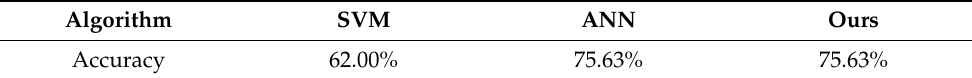
Table 6. The average prediction precision in Stage 1 (after 550 hours of